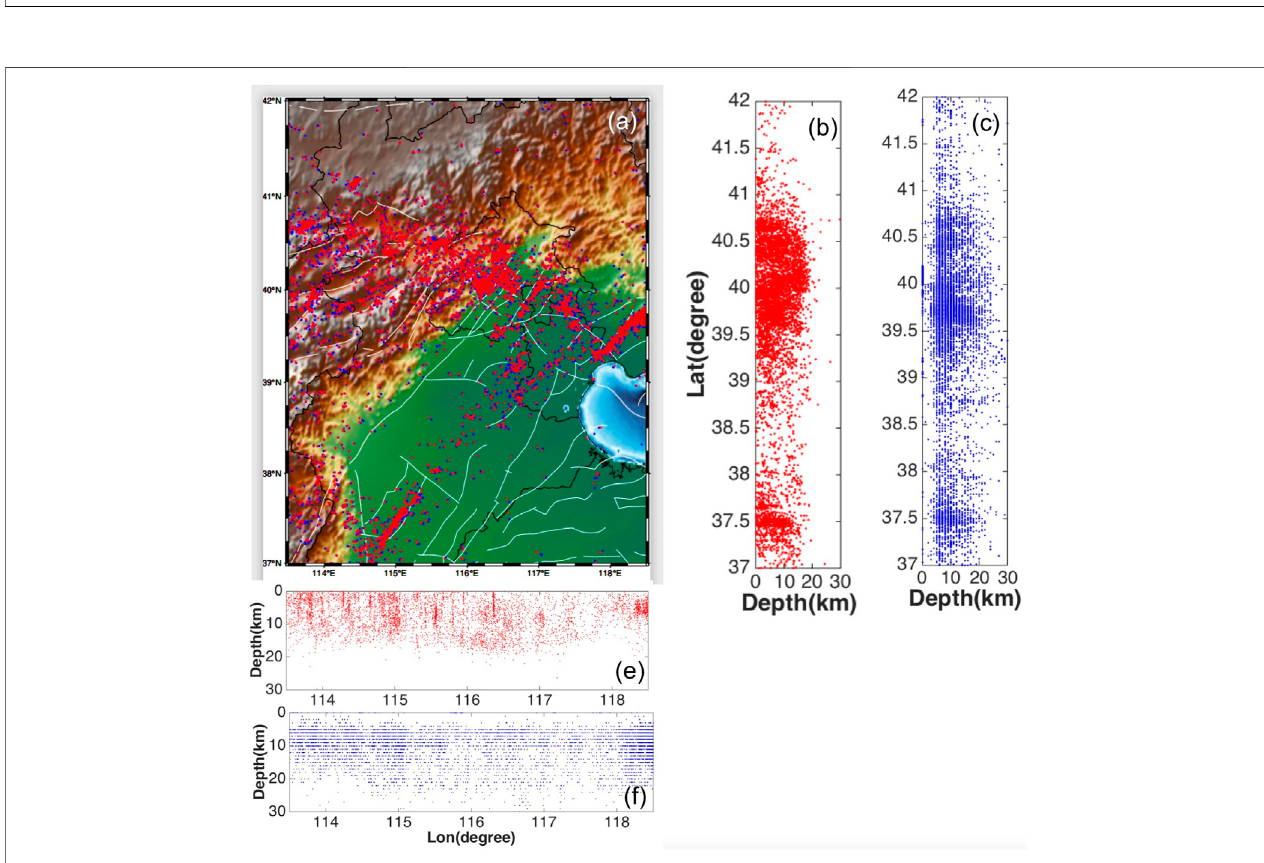
FIGURE 10 | Three views of the relocation (the red solid dots in (A) , (B) , and (E) ) and initial location (the blue solid dots in (A) , (C) , and (F) ) of epicenters.